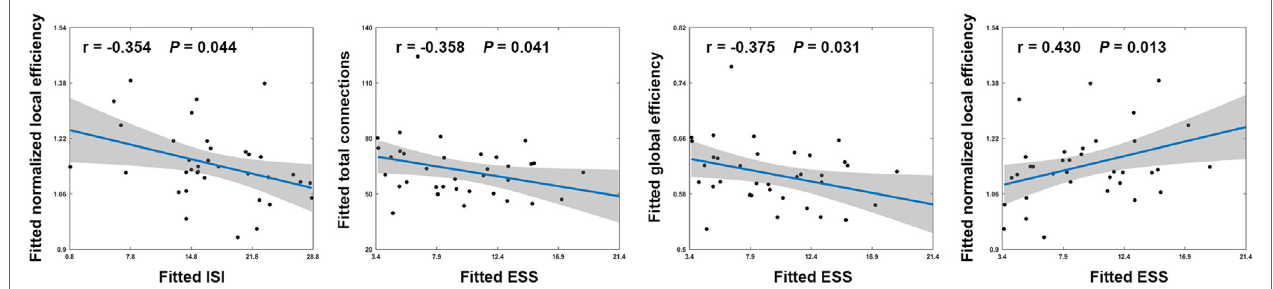
FigUre 4 | Scatter plots showing significant correlations between network measures and neuropsychological variables in patients with PI. Effects of age, sex, and education were controlled during the correlation analyses. Thus, the fitted values (i.e., the observed network measures and neuropsychological variables minus the estimated effects of age, sex, and education) that are plotted reflect the “true” relationships. ISI, Insomnia Severity Index; ESS, Epworth Sleepiness